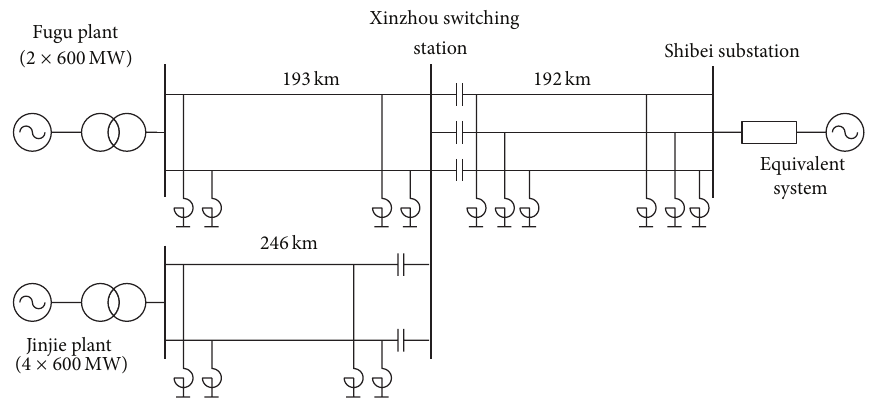
Figure 4: Single-line diagram of Jinjie power plant.